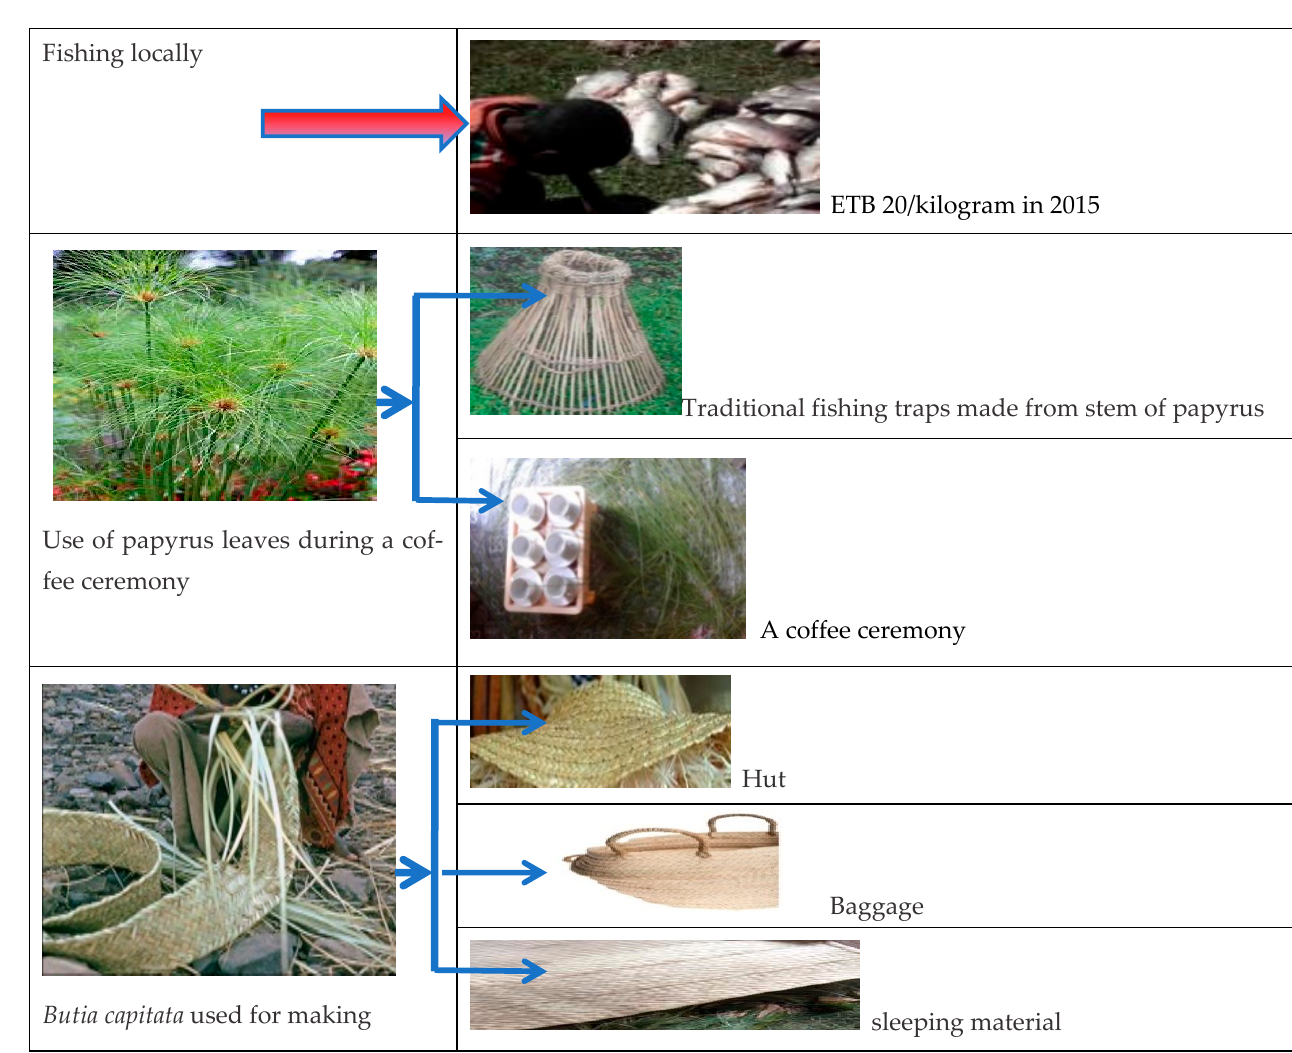
Figure 2. Types of traditional goods. Table 6. The influence of the rice market on traditional practice/knowledge.